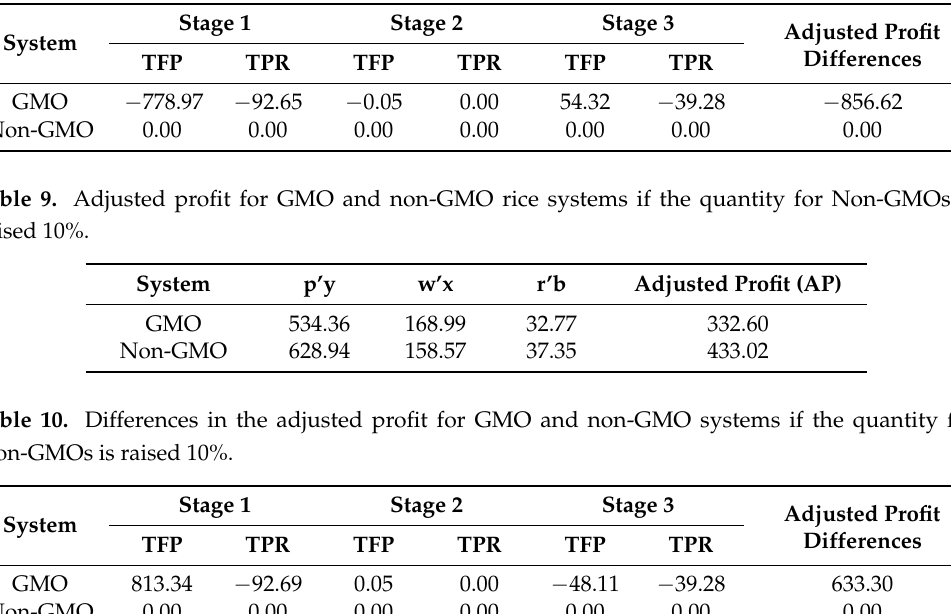
Table 8. Differences in the adjusted profit for GMO and non-GMO systems if the quantity for GMOs is raised 10%.